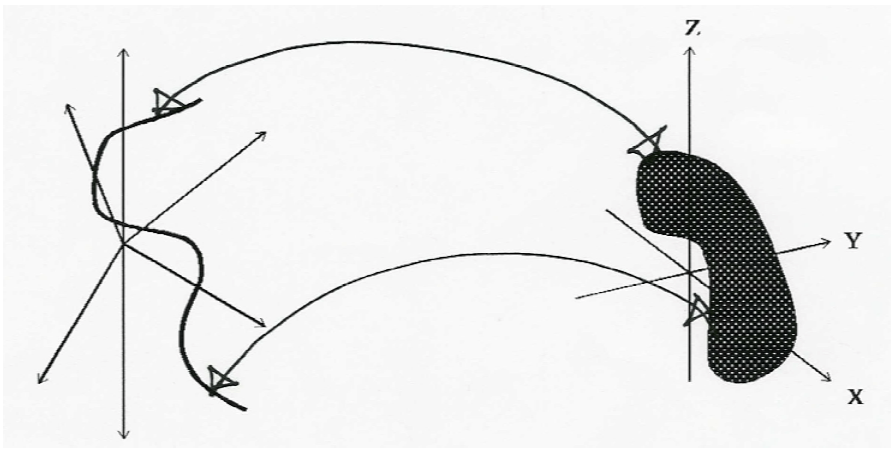
FIGURE 2. The living organism is projected to a multidimensional room of chemical gradients[10].